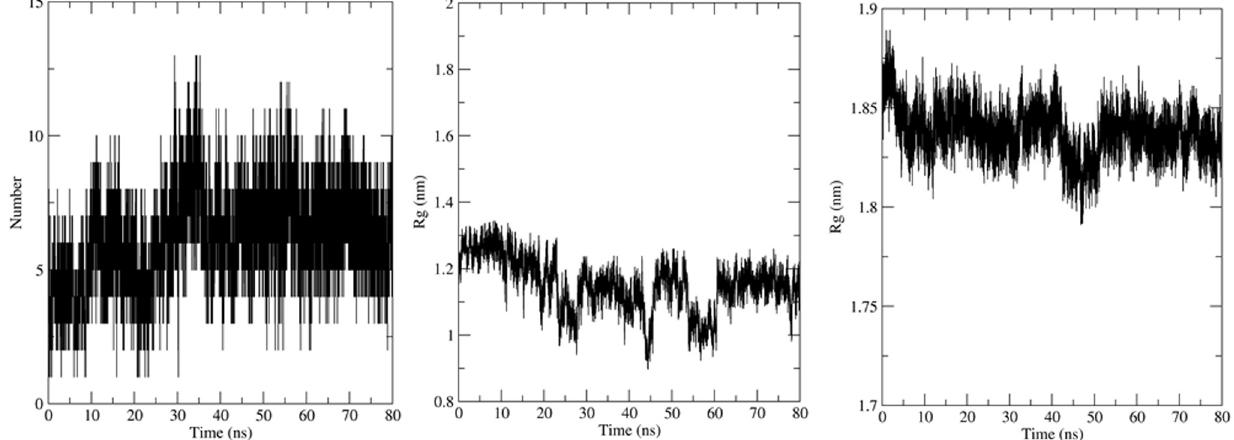
Fig 10. (a) Number of Hydrogen bonds in the MD simulation. (b) Radius of gyration of Peptide 7 in the complex (c) MERS- CoV RBD in the complex.